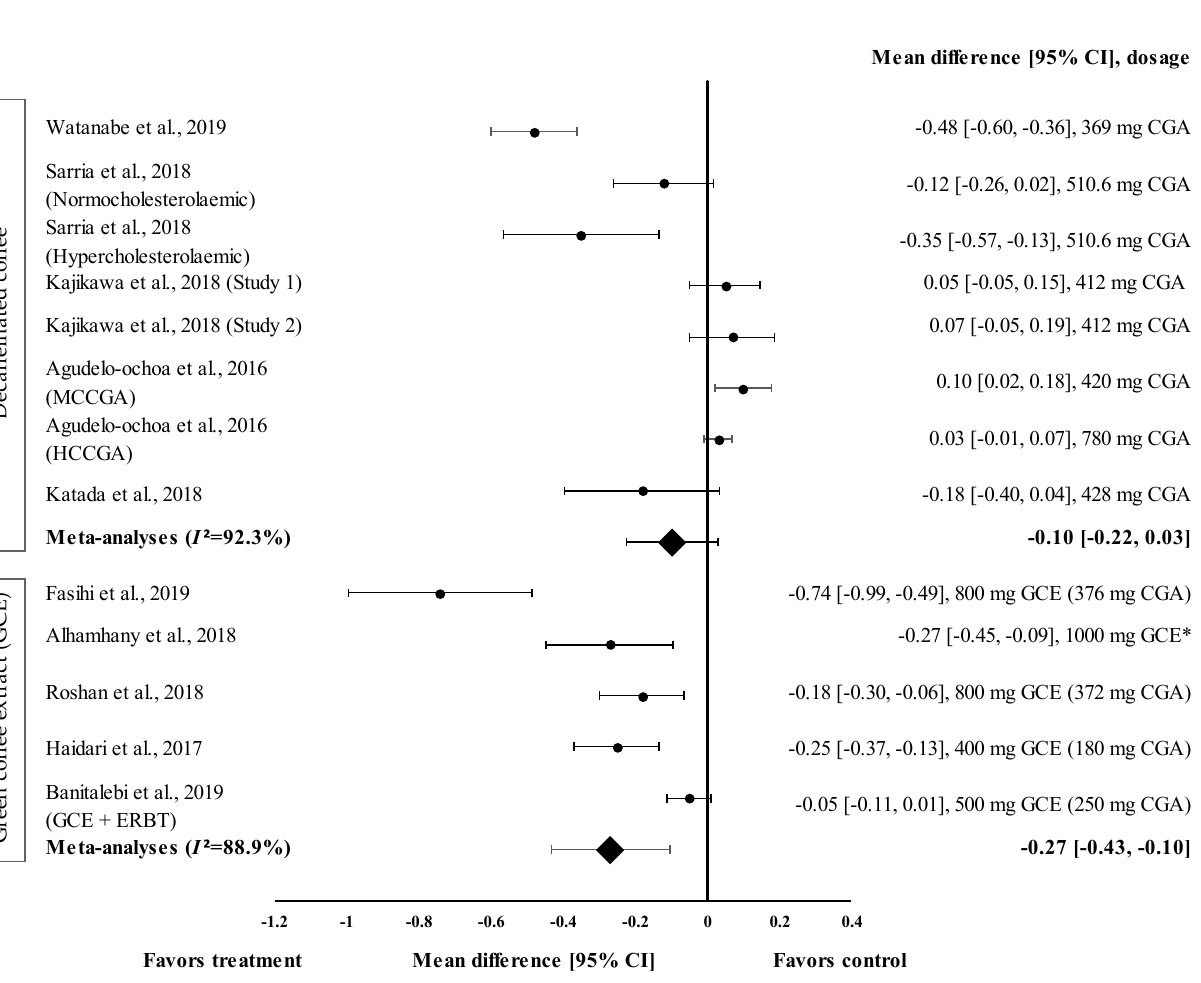
Figure 4. Forest plot showing the effect of decaffeinated coffee and GCE on TG levels, expressed as mean differences between the values obtained in the intervention and control groups. A negative effect size indicates that decaffeinated coffee and GCE supplements reduce TG levels. Meanwhile, a positive effect size indicates that decaffeinated coffee increases TG levels. Horizontal lines represent the 95% CIs. Diamonds represent the pooled effect size from the random effect analysis. CGA: chlorogenic acid, CI: confidence interval, ERBT: elastic resistance band training, GCE: green coffee extract, HCCGA: high CGA content, MCCGA: medium CGA content, TG: triglyceride. The values ± 0.2, ± 0.5, and ± 0.8, represent small, medium, and large effect sizes, respectively. * CGA dose not specified